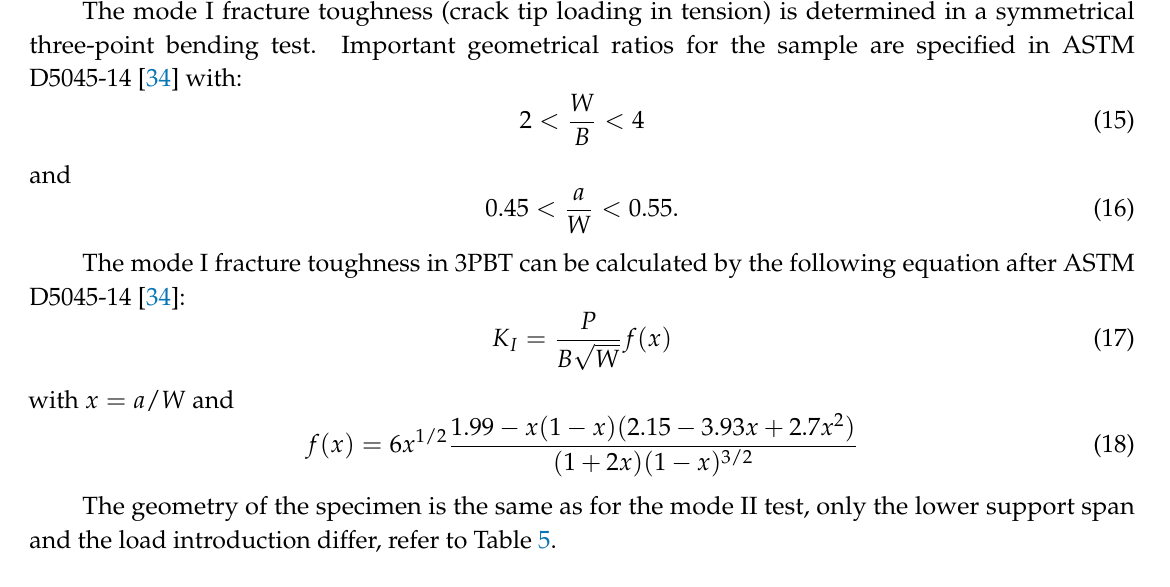
Table 5. Required dimensions of mode II